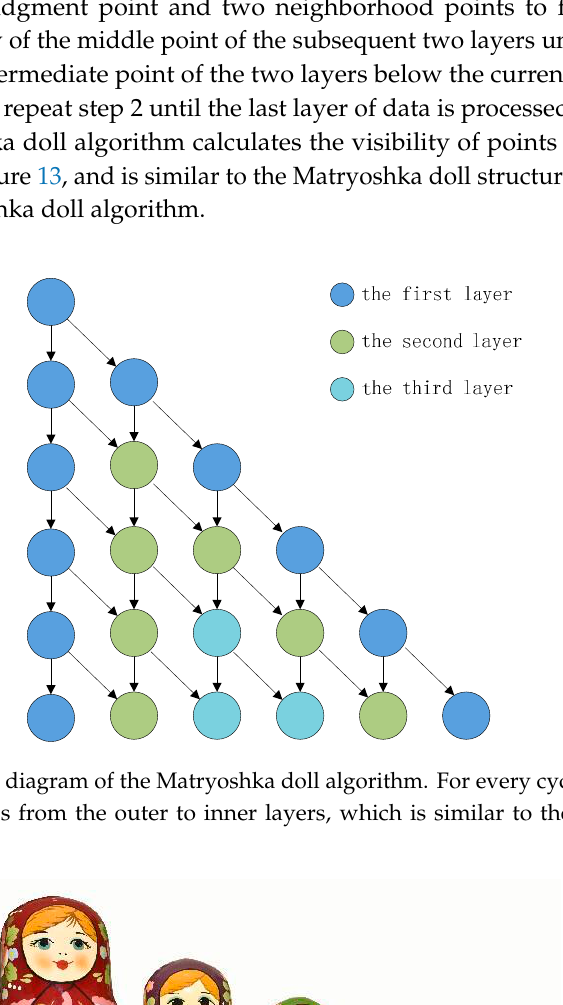
Figure 12. The steps in the proposed Matryoshka doll algorithm. Only one cycle of calculation for each part of the data is shown, and Step 1 selects the current judgment point (see algorithm). ( a ) is a schematic diagram of step 1 of the algorithm, and only the outermost dark blue nodes are involved in the calculation of this step. ( b ) is the schematic diagram of the second step and the green nodes